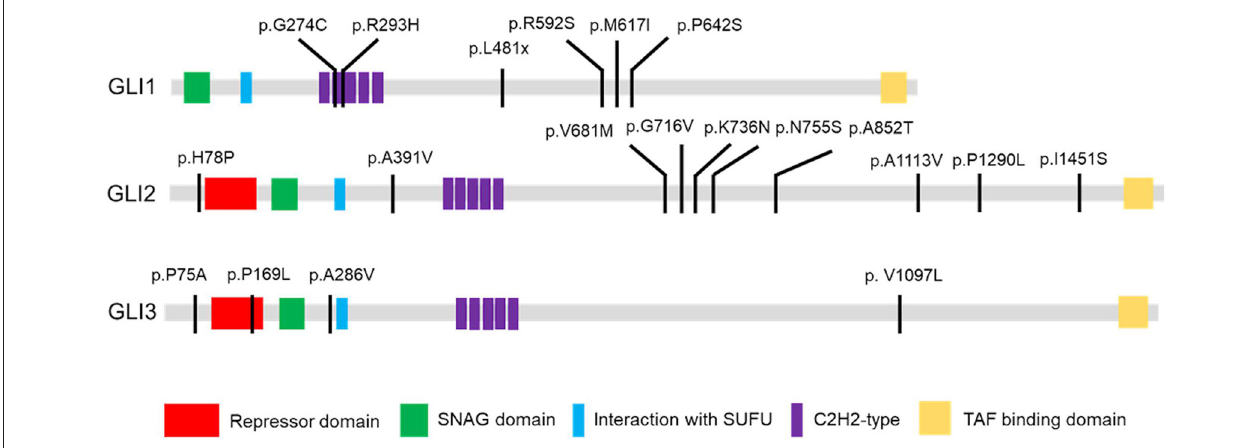
FIGURE 1 | GLI1-3 mutations were identified in CHD patients. Schematic diagram of case-specific mutations in GLI1, GLI2 and GLI3 protein.